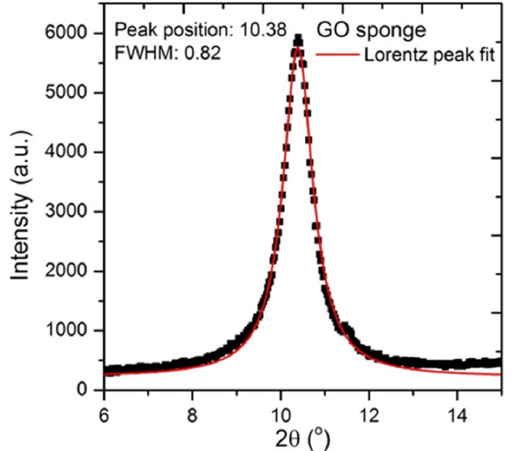
Figure A6. Raman spectrum of GO used in the preparation of the alginate beads.